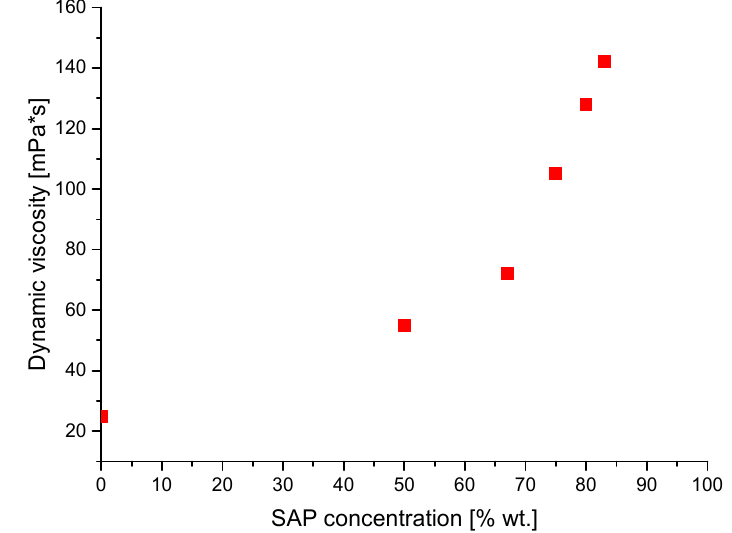
Figure 12. Dynamic viscosity as a function of SAP concentration in BaTiO 3 suspension.